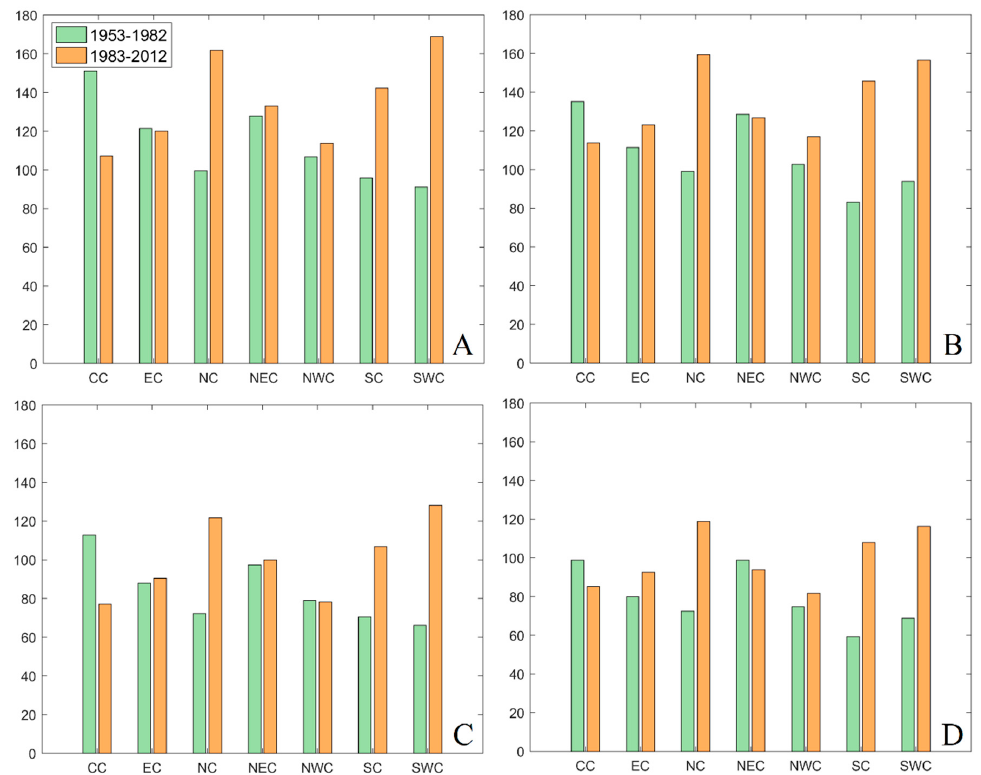
Figure 5. Changes in the frequency (days) of compound droughts and hot extremes for the two periods 1983–2012 and 1953–1982 for different regions in China. ( A ): SPI3 < –0.5; ( B ): SPI6 < –0.5; ( C ): SPI3 < –0.8; ( D ): SPI6 < –0.8.